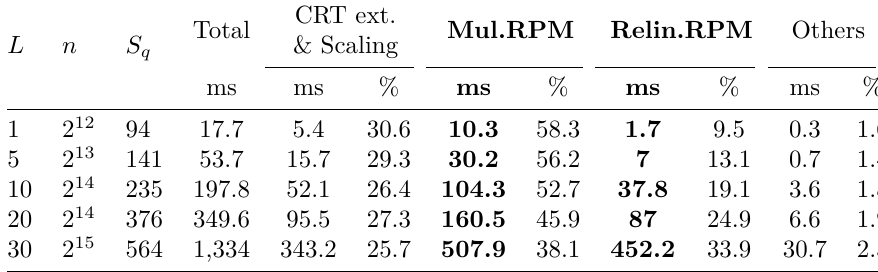
Table 3: Timing estimate derived from the profiling result of [HPS18]. Single-threaded mode, Linux CentOS, Intel Core i7-3770 CPU 4 cores at 3.40GHz and 16 GB of RAM; plaintext space t = 2, s ≈ 47, security λ >